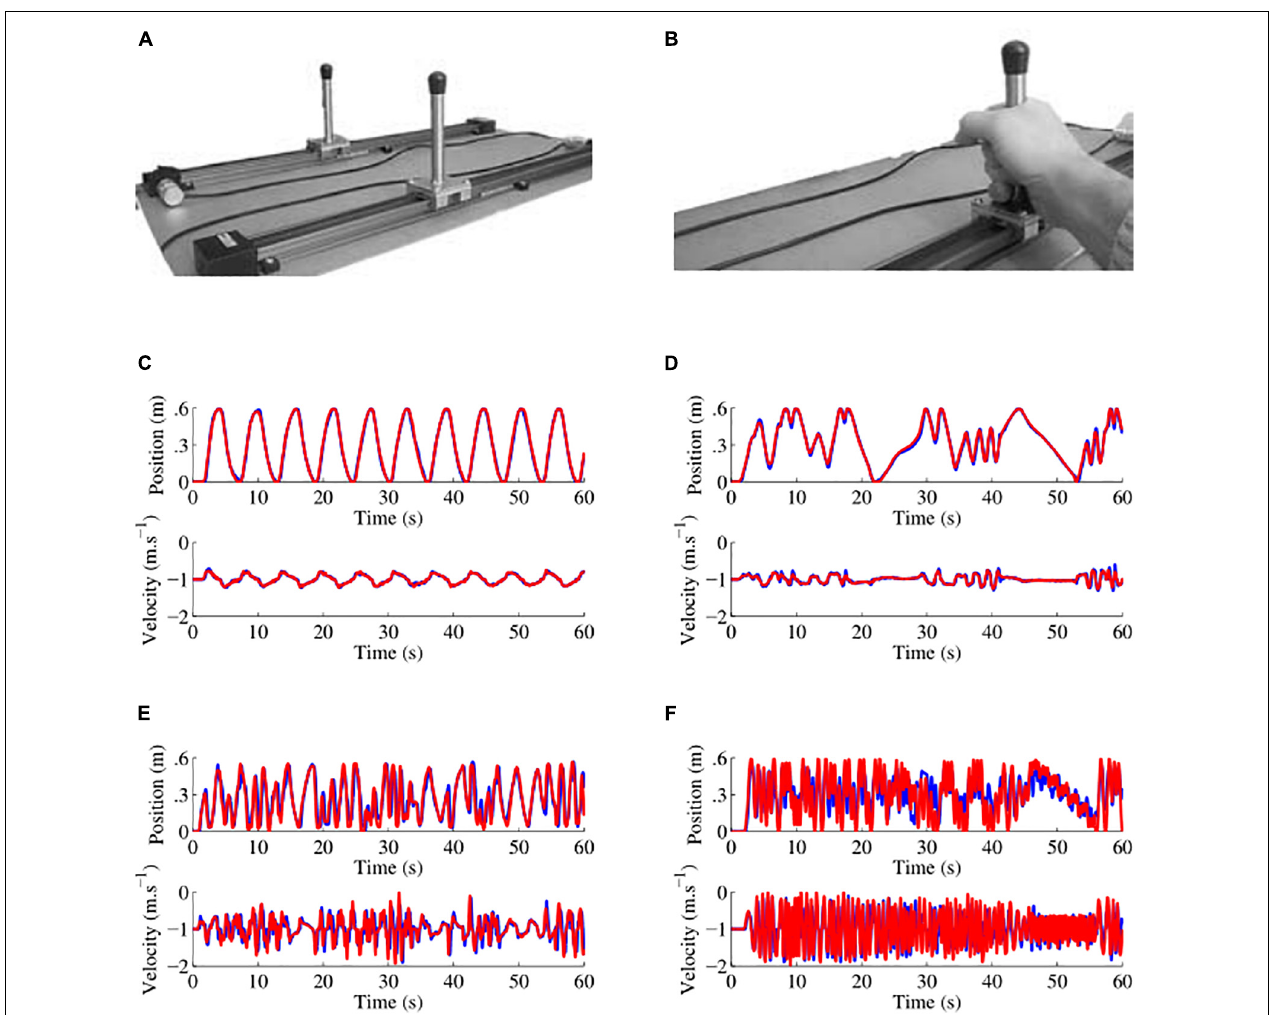
FIGURE 1 | Custom hardware apparatus and examples of data collected. (A) Picture of the apparatus used to play the mirror game, the motion of two players moving handles along 0.6 m tracks was sampled at 100 Hz with a spatial resolution of 0.054 mm. (B) Handles were held with one or two hands depending on participant preference. (C–F) Examples of position and velocity traces for four different players in the first round where the participant led the game. Here the leader is the red player. In (C) the traces are those of a schizophrenia patient with a socio-motor improvisation of 0.037 and a socio-motor synchronization of 0.998. In (D) the traces are those of another schizophrenia patient with a socio-motor improvisation of 0.040 and a socio-motor synchronization of 0.984. In (E) the traces are those of a healthy control with a socio-motor improvisation of 0.092 and a socio-motor synchronization of 0.867. In (F) the traces are those of another schizophrenia patient with a socio-motor improvisation of 0.108 and a socio-motor synchronization of 0.716.